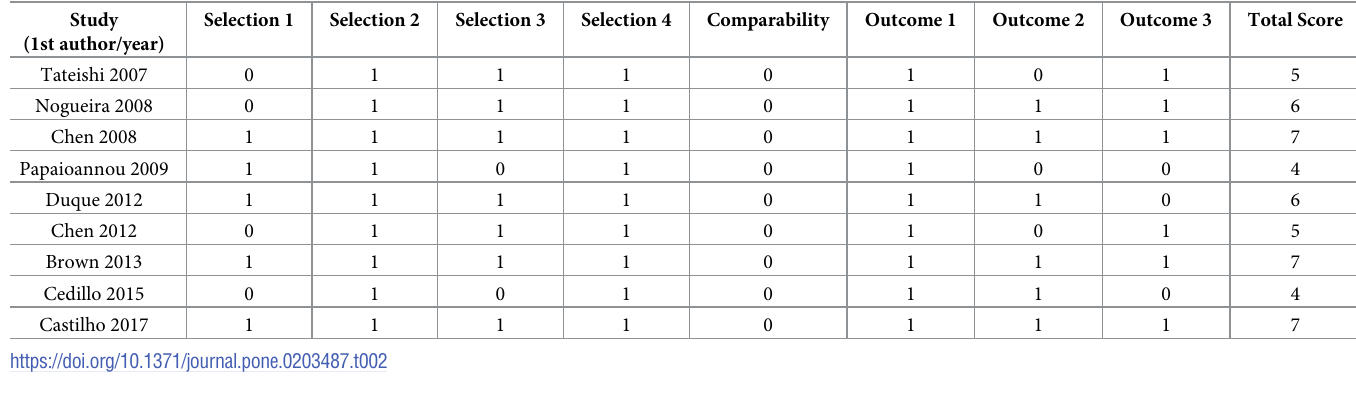
Table 2. Newcastle-Ottawa Scale.